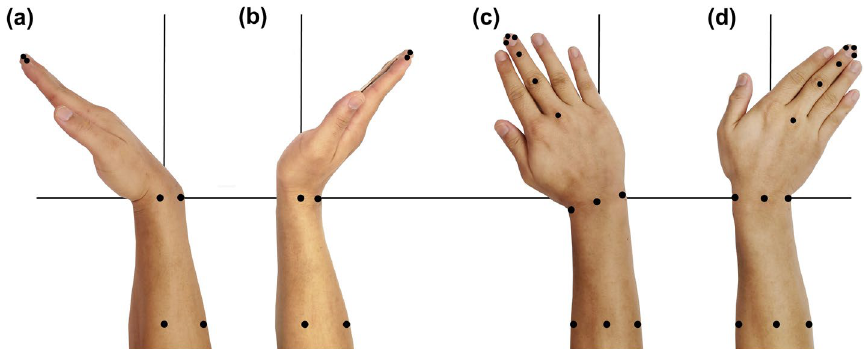
Fig. 2 Measurement postures for the wrist range of motion: ( a ) flexion, ( b ) extension, ( c ) radial and ( d ) ulnar deviations